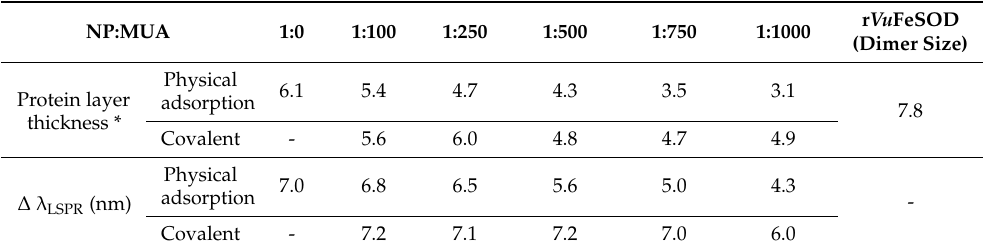
Table 1. Protein layer thickness and LSPR shift (nm) of AuNP–VuFeSOD conjugates (physical adsorption and covalent